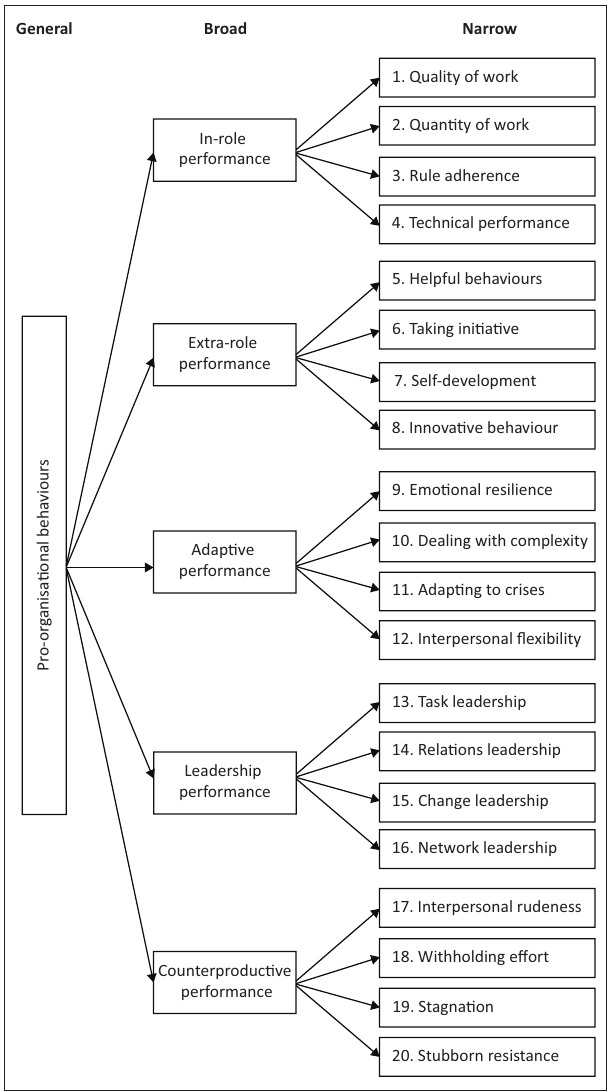
FIGURE 1: Performance levels of the individual work performance review (IWPR).